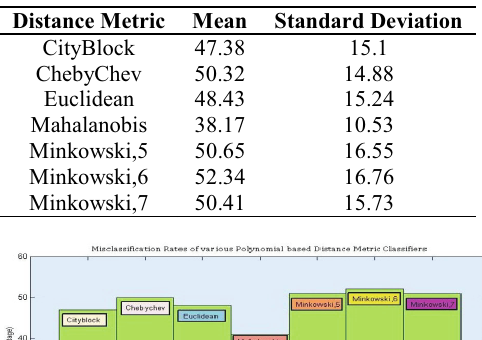
Table 14. Statistical Error measurement for Polynomial based distance metrics